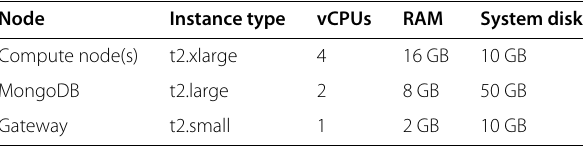
Table 2 Used AWS instance